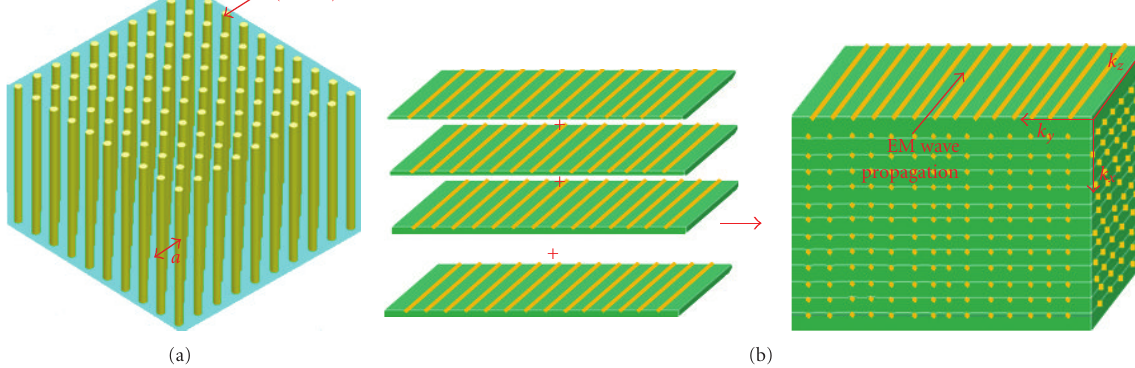
Figure 4: (a) Schematic illustration of a wired medium design. (b) Illustration of the HMM slab structure (yellow-metal wires), green (PCB slab).